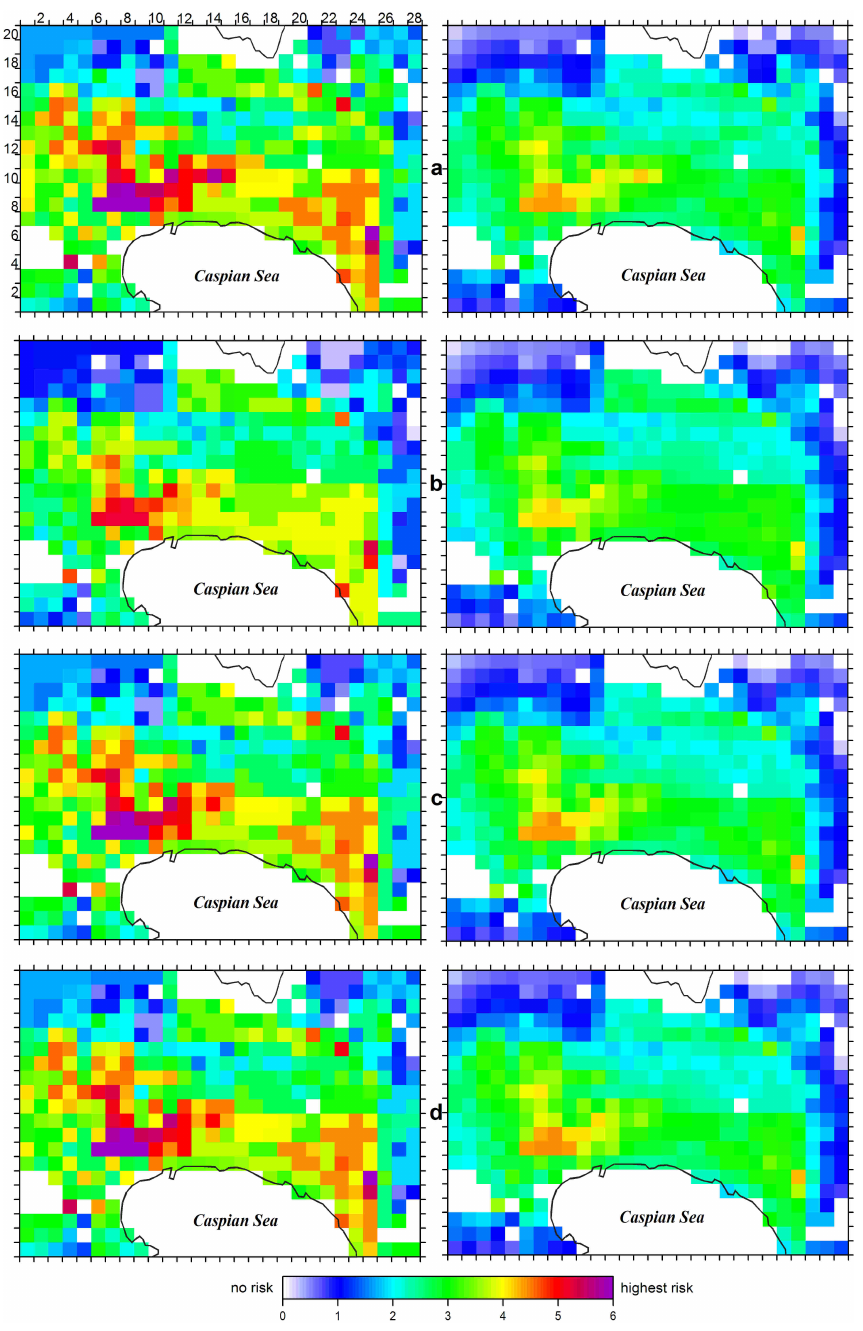
Fig. 9. Earthquake risk models for four earthquake scenarios: ( a ) near event; ( b ) local event; ( c ) far event, and ( d ) extreme event. The left and right panels present the model results for the weighted parameter β = 10 10 and β = 10 3 ,